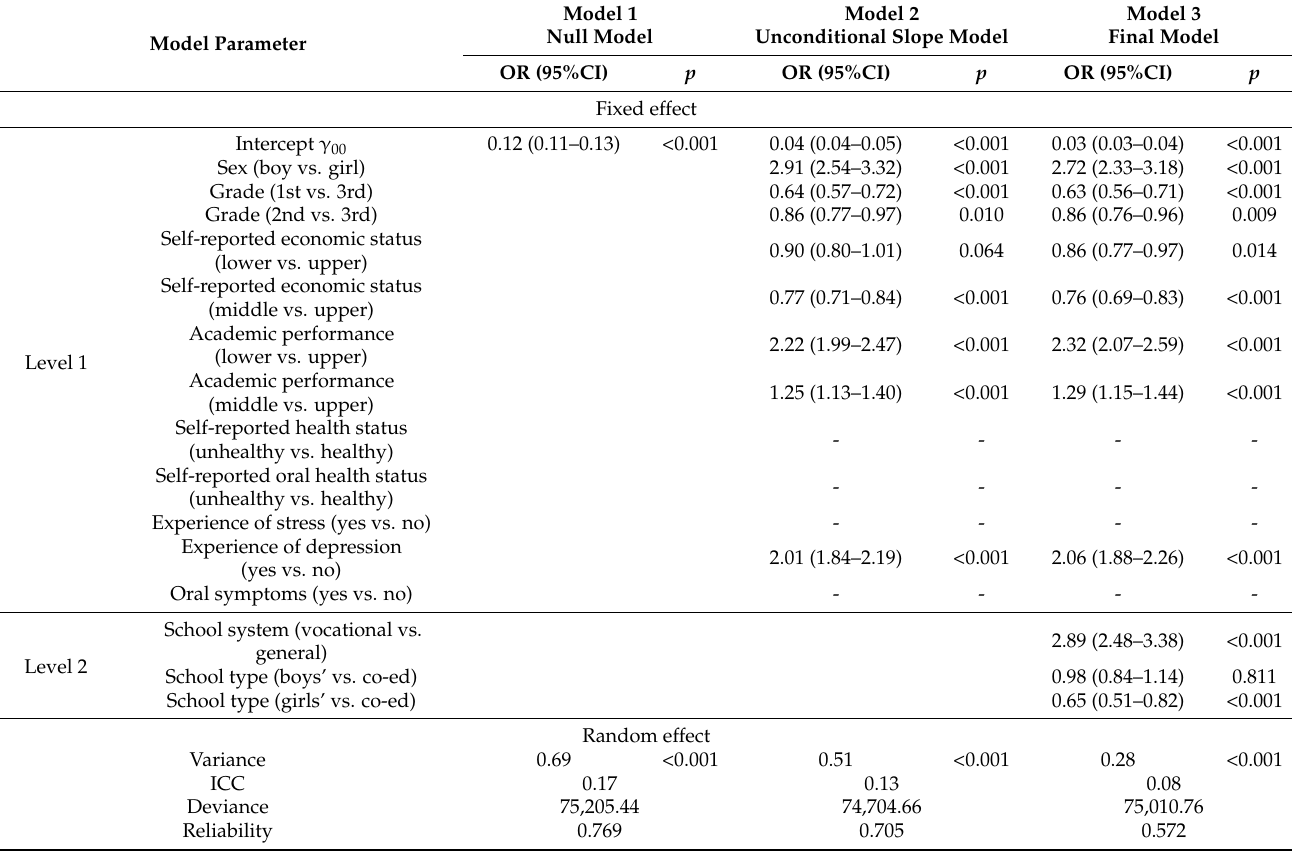
Table 5. Multilevel analysis of students’